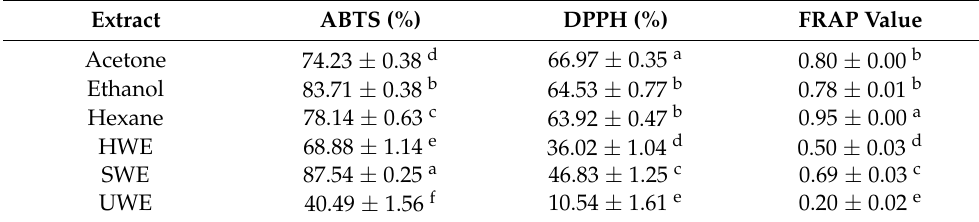
Table 7. Determination of antioxidant activities from wheat germ extracts.